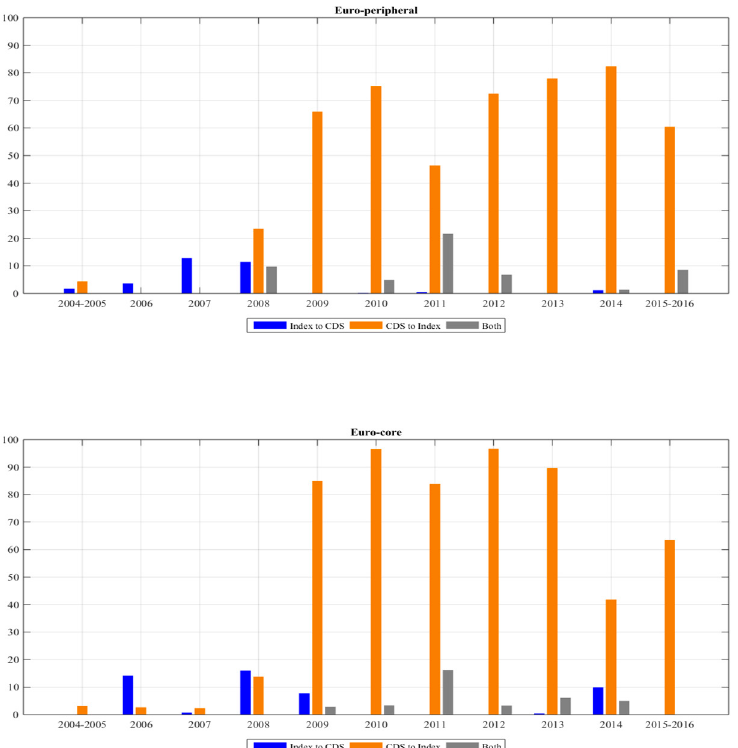
Figure 6. Granger causality test results by year and zones between stock return conditional volatility and sovereign CDS returns during the period 6 January 2004–12 April 2016. For each zone and year, we present the number of times (in percentage) that the null hypothesis of Granger causality is rejected. We present results together for 2004–2005 and 2015–2016 due to the limited data available for 2004 and 2016 (the rolling estimation starts on 24 / 12 / 2004 and finishes on 12 / 4 / 2016). Blue, orange and grey bars show if the stock market Granger-causes sovereign CDS returns, vice versa or both.